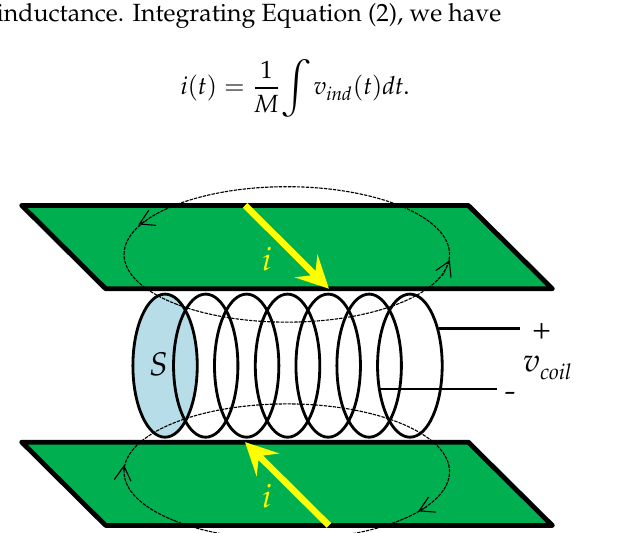
Figure 1. PCB-embedded pick-up coil structure.